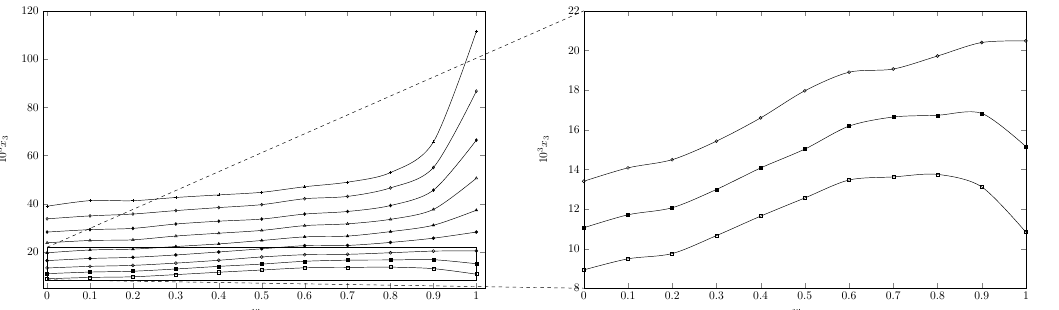
Figure 2. Molar fraction of isoniazid (10 3 x 3 ) depending on the cosolvent composition (mass fraction) free of solute. (cid:3) : 278.15 K; (cid:4) : 283.15 K; ♦ : 313.15 K, and +: 318.15 K.